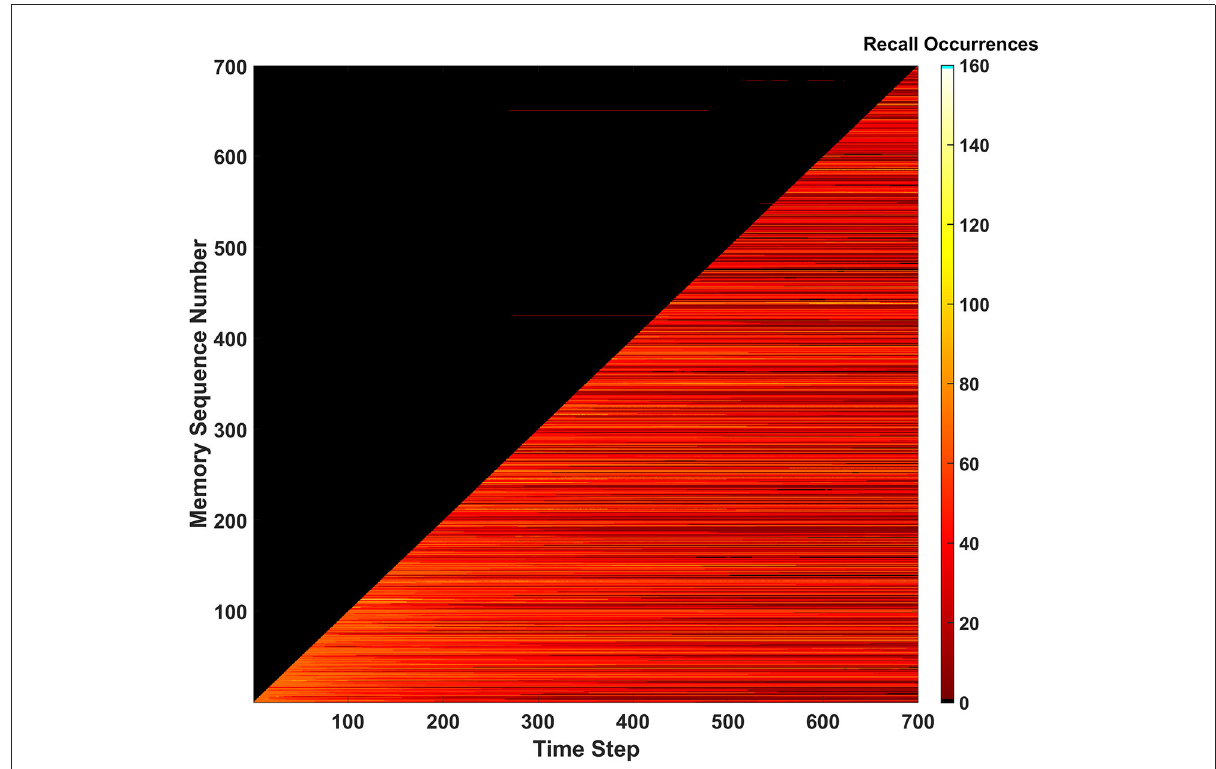
FIGURE5 Recall occurrences heatmap for the basic SAN run against the EHoS dataset. This heatmap shows how many times at each time step a specific memory within the dataset was recalled. Memories are sorted along the y-axis with respect to the order in which they are shown to the